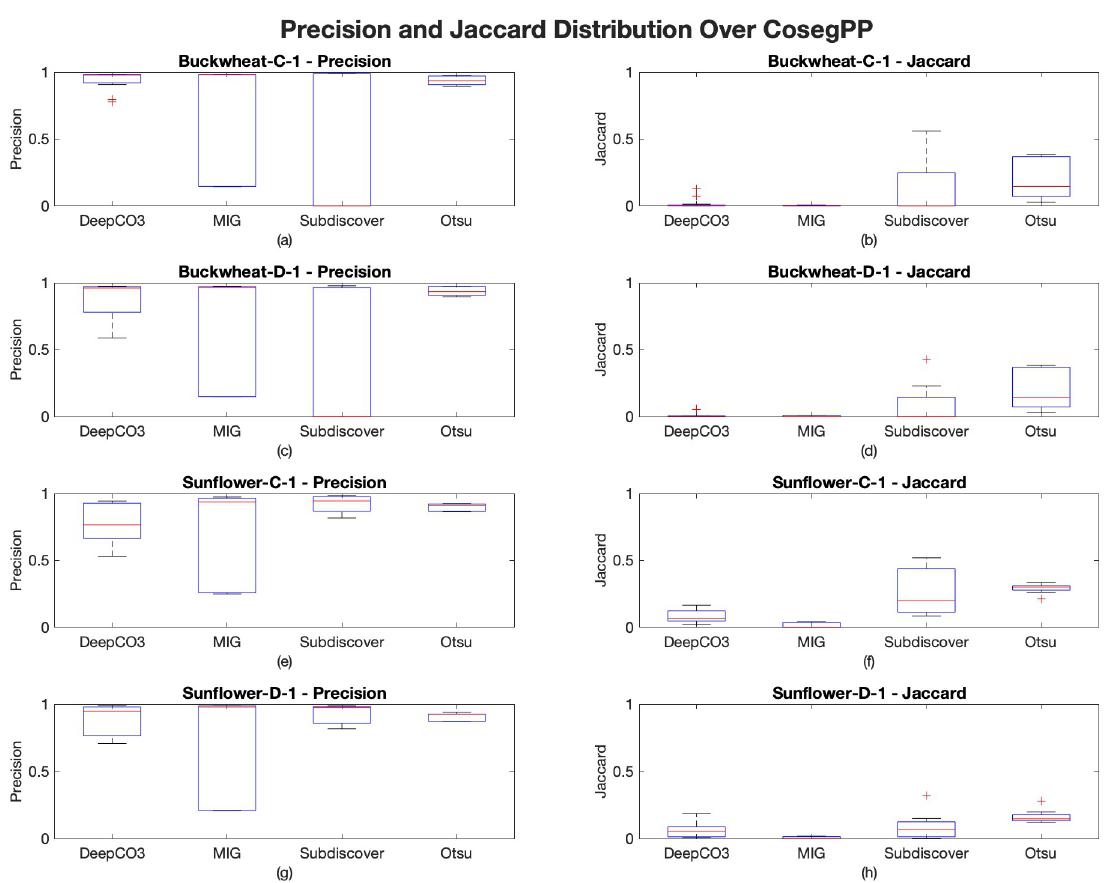
Fig 4. Precision and Jaccard distribution over CosegPP from the benchmark analysis. (a) and (b) are Precision and Jaccard distributions for Buckwheat-C-1, respectively. (c) and (d) are the Precision and Jaccard distributions for Buckwheat-D-1, respectively. (e) and (f) are the Precision and Jaccard distributions for Sunflower-C-1, respectively. (g) and (h) are the Precision and Jaccard distributions for Sunflower-D-1, respectively.